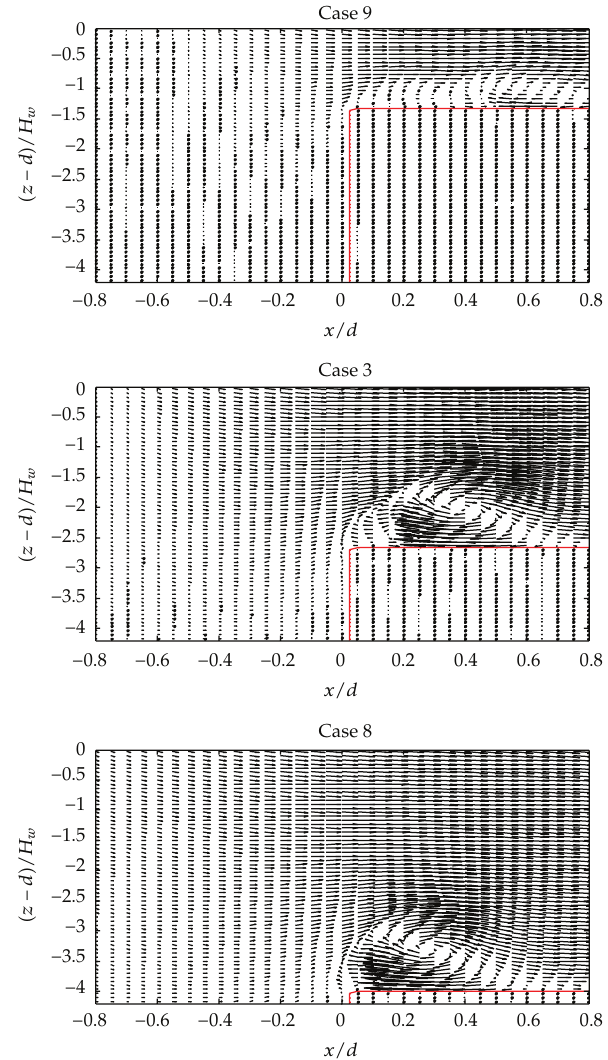
Figure 8: Velocity field at t (cid:2) g/d (cid:3) 0 . 5 (cid:7) 49 as a solitary wave passes over a submerged breakwater with di ff erent height h (cid:7) 4 . 0m (cid:2) Case 9 (cid:3) , h (cid:7) 3 . 0m (cid:2) Cases 3 (cid:3) , and h (cid:7) 2 . 0m and (cid:2) Case 8 (cid:3)